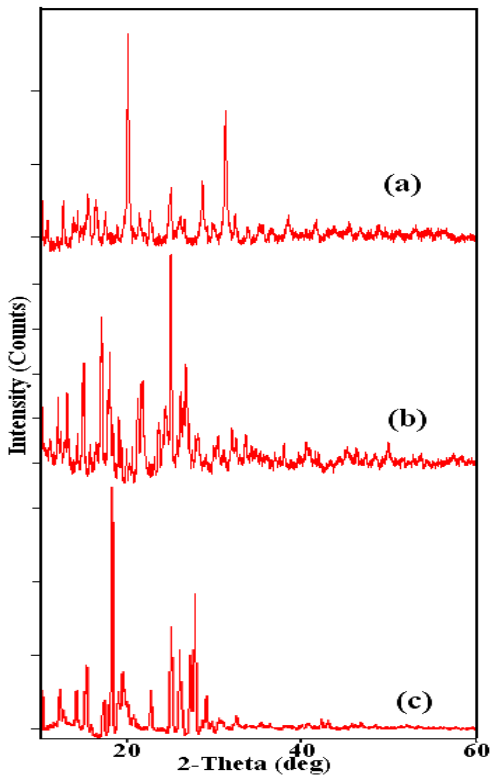
Figure 8. X-ray powder diffraction (XRD) patterns of ( a ) Cu(II), ( b ) Zn(II), and ( c ) Co(II) complexes.